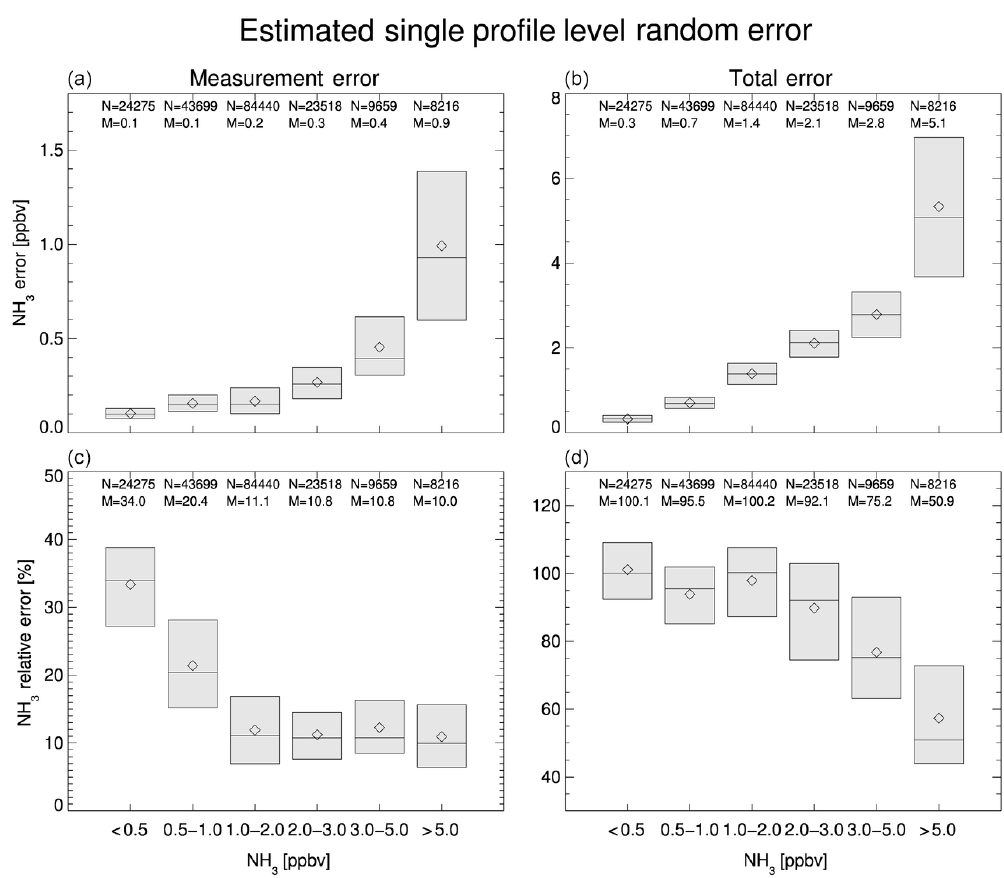
Figure 4. Errors for the individual for all profile levels below 700hPa ( ∼ 3km) using the same plotting criteria as in Fig. 3.